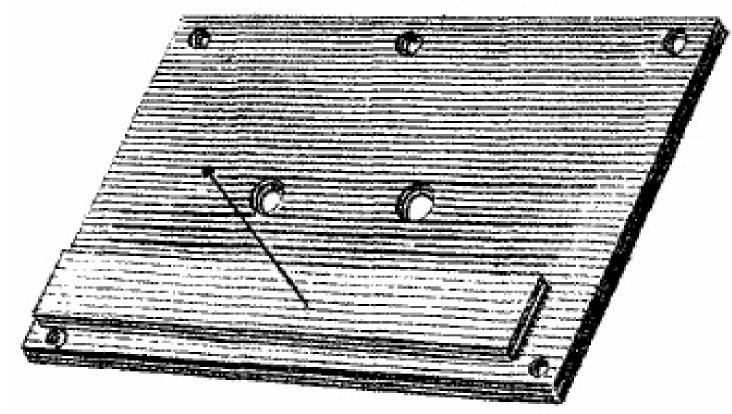
Figure 8. Measurement stand for infrared radiation transmission test—original drawing of the measurement stand